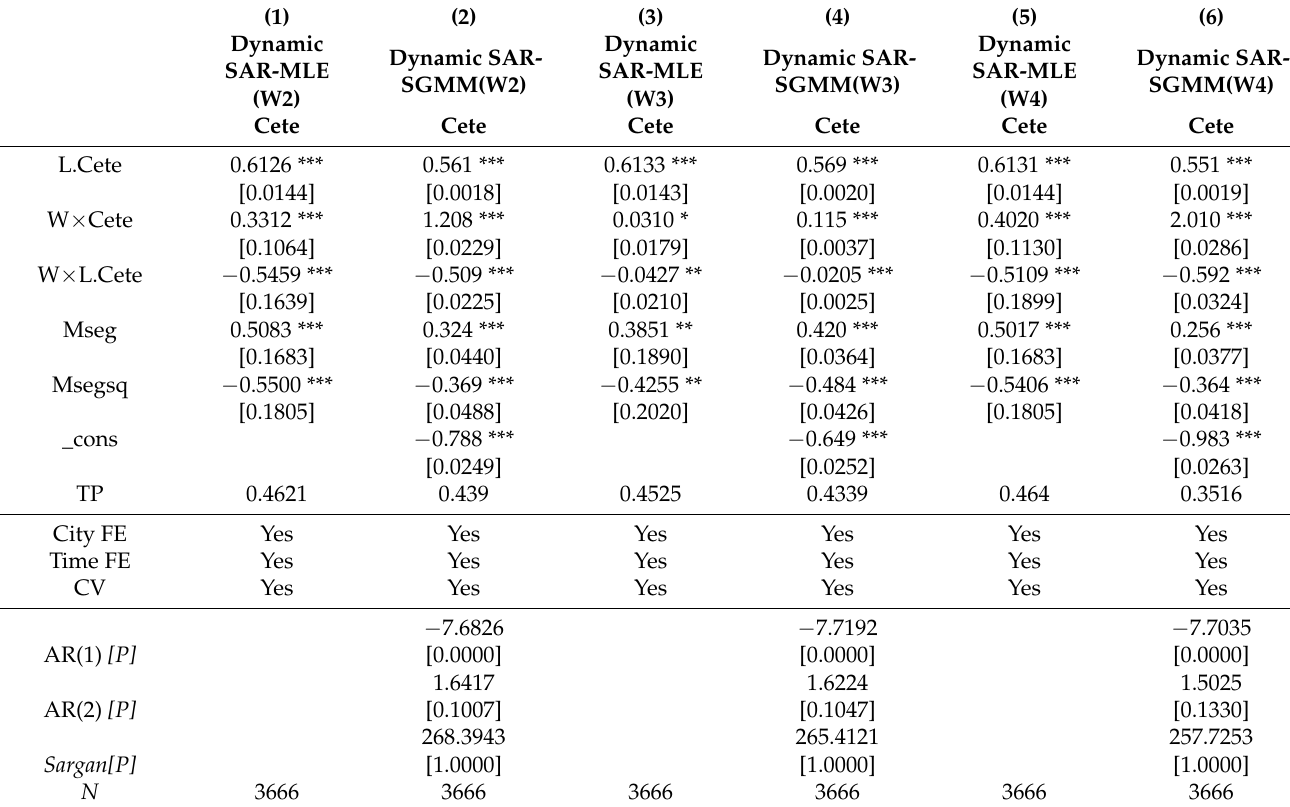
Table 6. Regression results of dynamic spatial panel